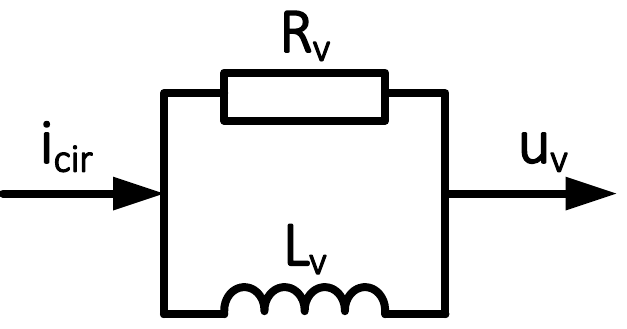
Figure 5. Virtual impedance equivalence diagram.